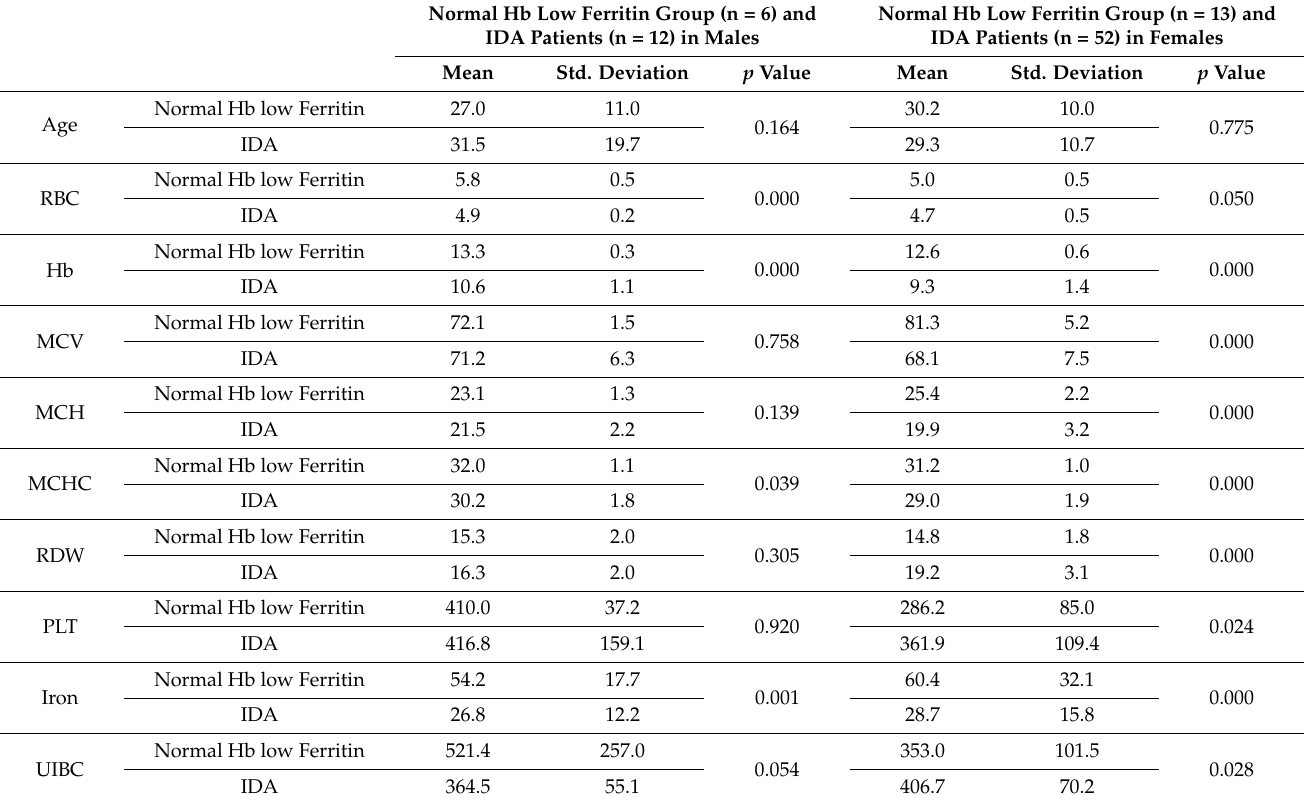
Table 3. Clinical data of normal Hb individuals with low iron stores and patients with IDA by